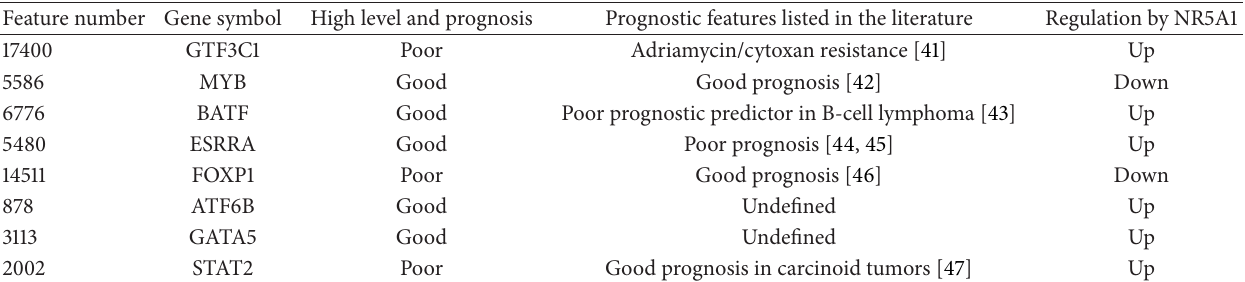
Table 2: Summary of eight transcription factors regulated by NR5A1 predicting favorable prognostic values. Feature number Gene